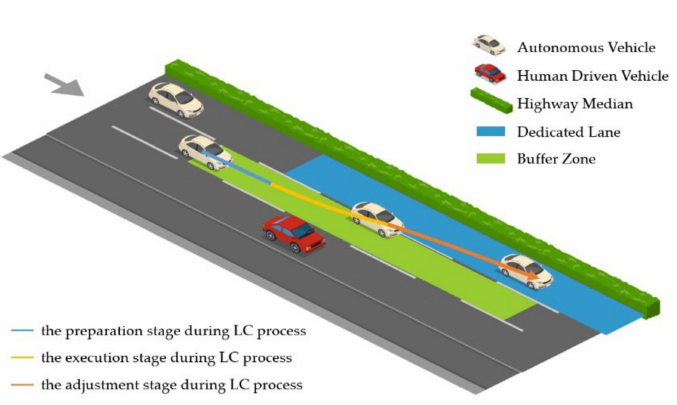
Figure 5. Diagram of the buffer zone for lane-changing